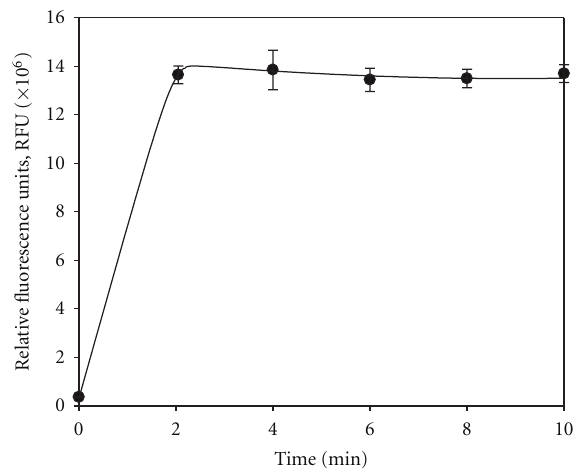
Figure 1: Release of dipicolinic acid (DPA) from a bacterial spore suspension of B. megaterium in relation to the duration of the microwave treatment. Points represent mean values of 8 replicates.